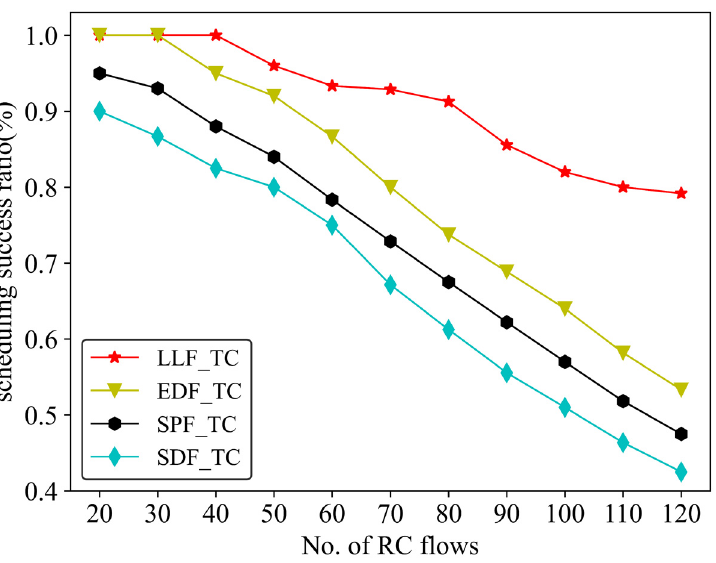
Figure 9. Success ratio of RC traffic scheduling with different shaping methods.